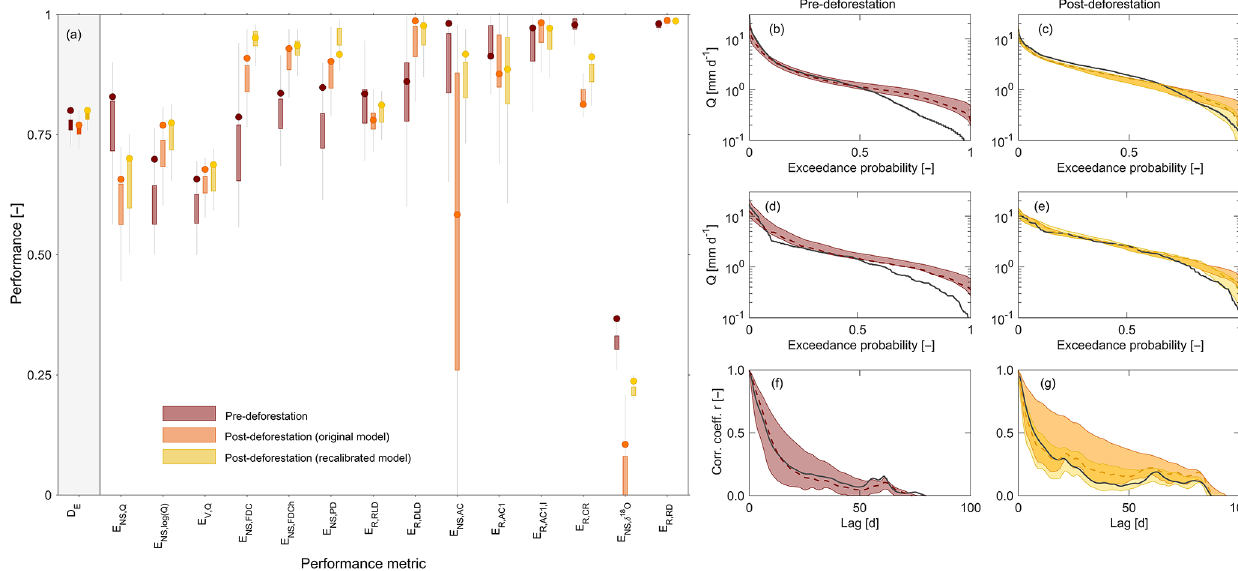
Figure 6. (a) Model performance metrics for all variables and signatures. D E is the Euclidean distance to the perfect model. It combines all other performance metrics (Table 3) into one number (Eq. 42). All performance metrics are formulated in a way that a value of 1 indicates a perfect fit. The boxplots summarize the performances of all parameter sets retained as feasible. The circle symbols indicate the performance of the best-performing model in terms of D E . The dark-red shades indicate pre-deforestation model performance based on calibration in the pre-deforestation period. Orange shades indicate post-deforestation performance using the pre-deforestation parameter sets without further re-calibration. Yellow shades show the post-deforestation performance after model re-calibration in the post-deforestation period. (b, c) show flow duration curves, (d, e) show the peak distributions and (f, g) show the autocorrelation functions for the pre- (red) and post-deforestation periods (orange and yellow), respectively. The black lines indicate the observed values, the dashed lines indicate the best fits and the shaded areas indicate the 5th / 95th uncertainty interval of all solutions retained as feasible. The dark-red shades indicate pre-deforestation model results based on calibration in the pre-deforestation period. Orange shades indicate post-deforestation model results using the pre-deforestation parameter sets without further re-calibration. Yellow shades show the post-deforestation model results after model re-calibration in the post-deforestation